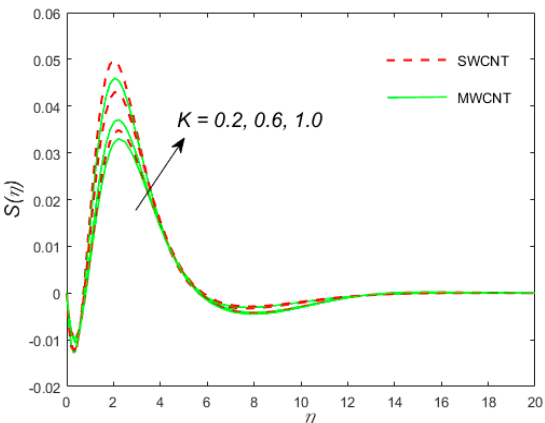
Figure 11. The impact of the temperature distribution profile θ ( η ) for the case of SWCNT and MWCNT versus the similarity variable for the distinct values of the magnetic parameter M .